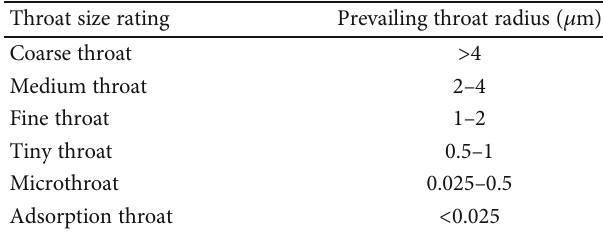
Figure 17: (a) Relation diagram of chloroform asphalt “ A ” and permeability of rock samples from Lucaogou formation. (b) Relation diagram of chloroform asphalt “ A ” and maximum pore throat radius of rock samples from Lucaogou formation. Table 5: Classi fi cation criteria for pore and throat in low permeability sandstone